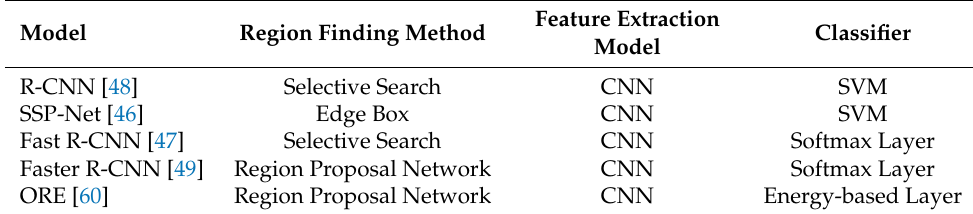
Table 3. Two-stage object detection